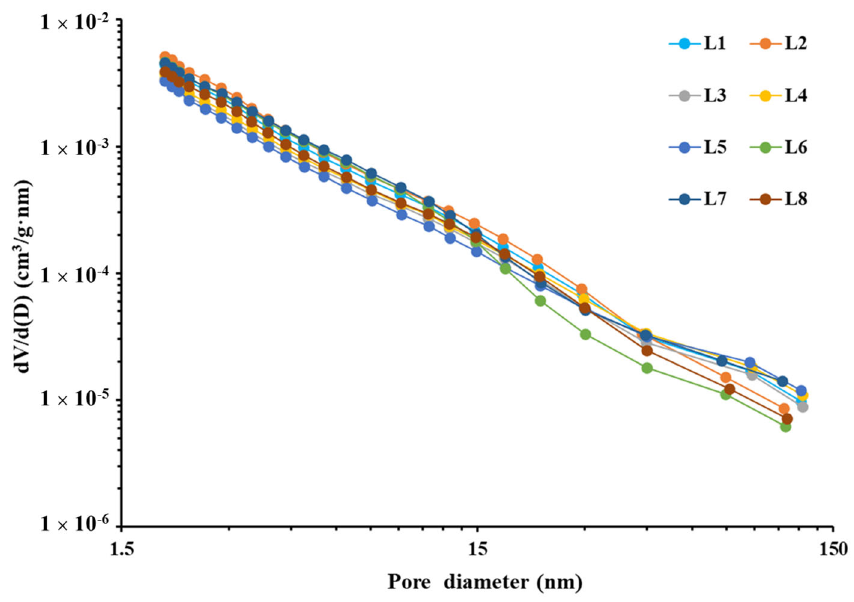
Figure 9. The pore size distribution curve of deep shale samples measured by LPNA.